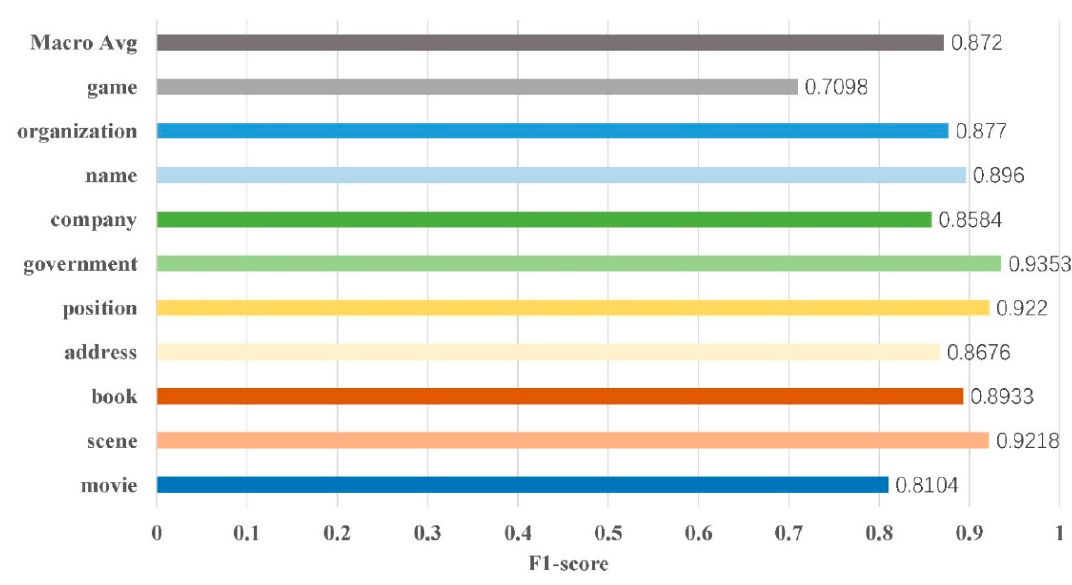
Figure 5. Statistical recognition results on CLUENER2020.